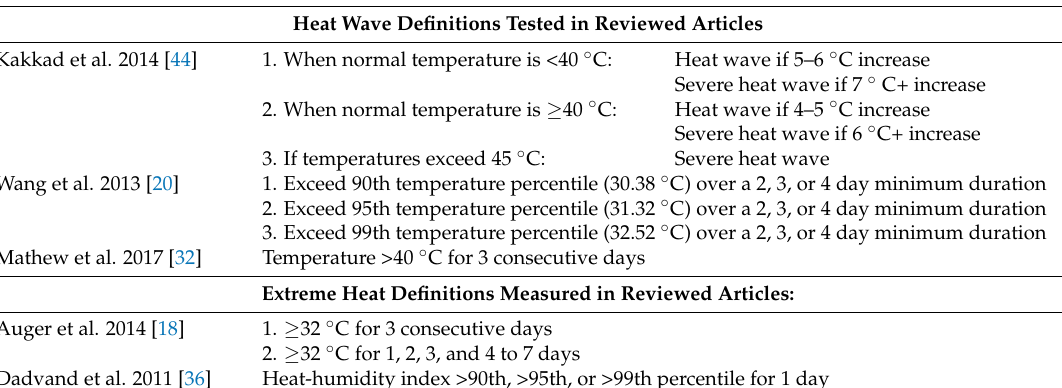
Table 2. Select heat wave and extreme heat definitions from reviewed